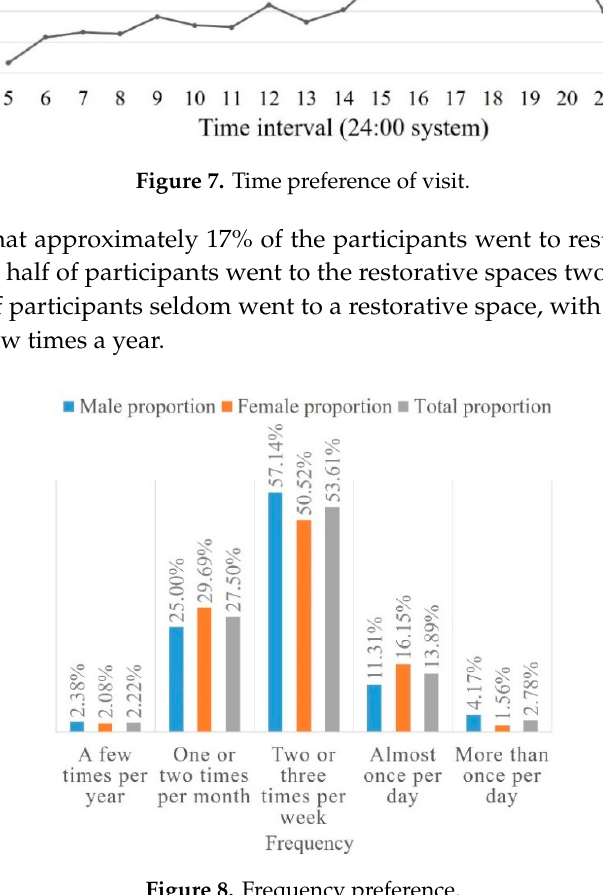
Figure 8. Frequency preference.